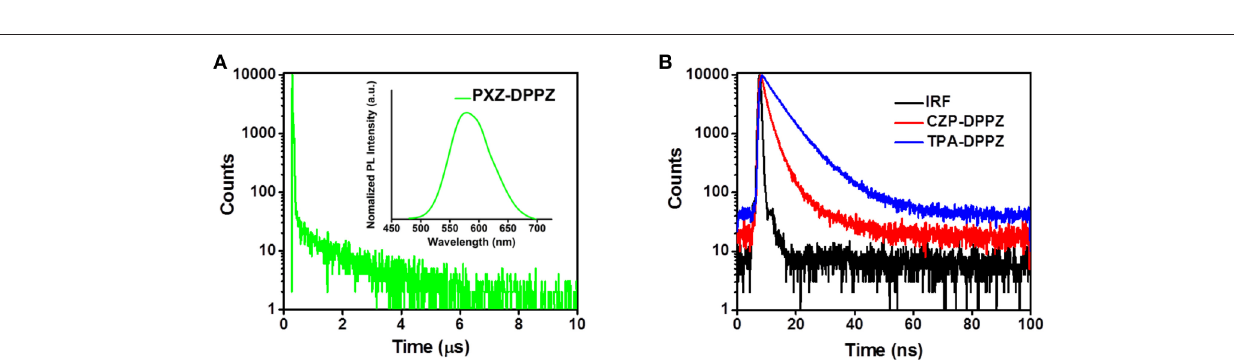
Frontiers in Chemistry |